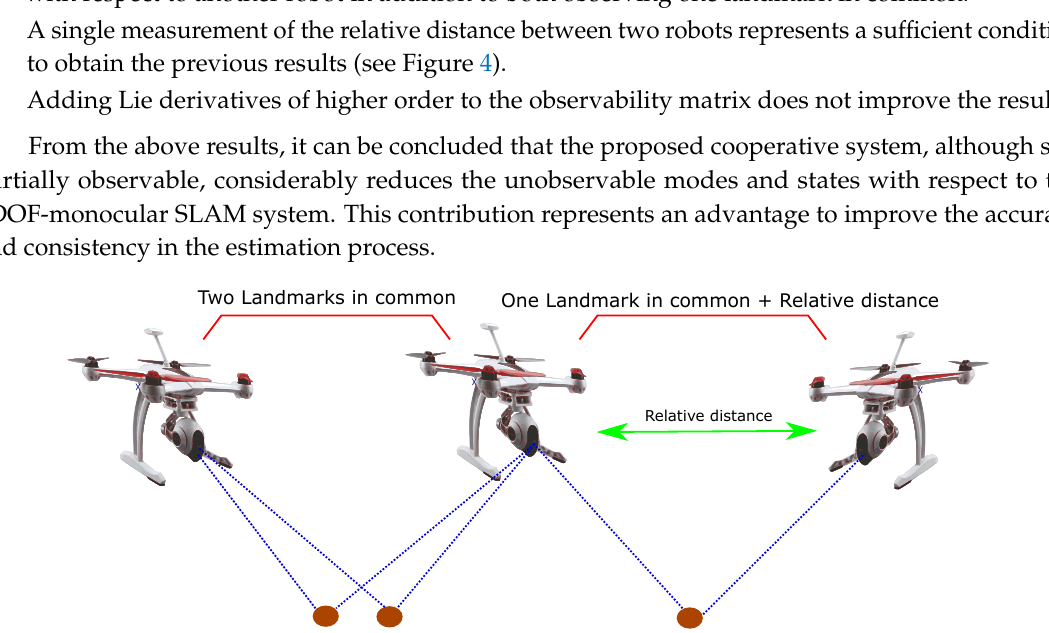
Figure 4. Requirements to obtain the results of the observability analysis for the proposed system.